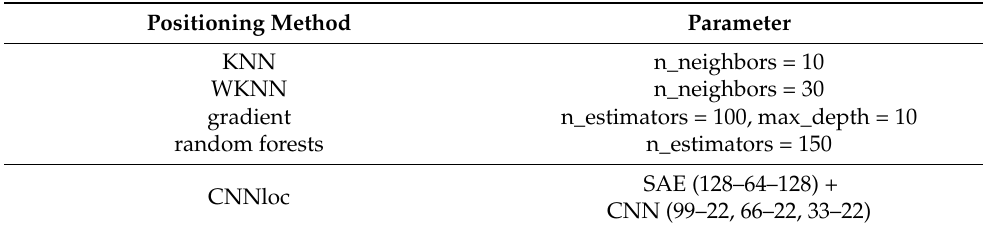
Figure 9. Positioning error with different methods on the UJIIndoorLoc dataset. Table 11. The algorithms and their parameters.